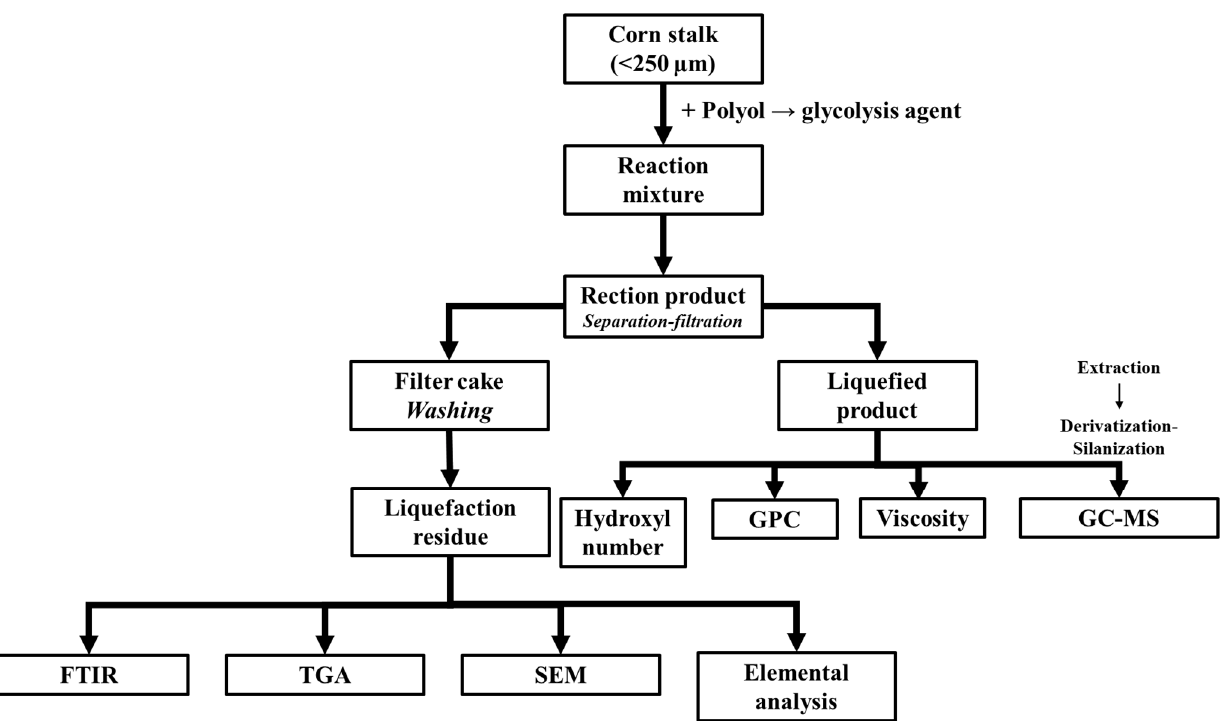
Figure 4. Flowchart for the research and development of lignocellulose glycolysis process (Adapted from [47] ).